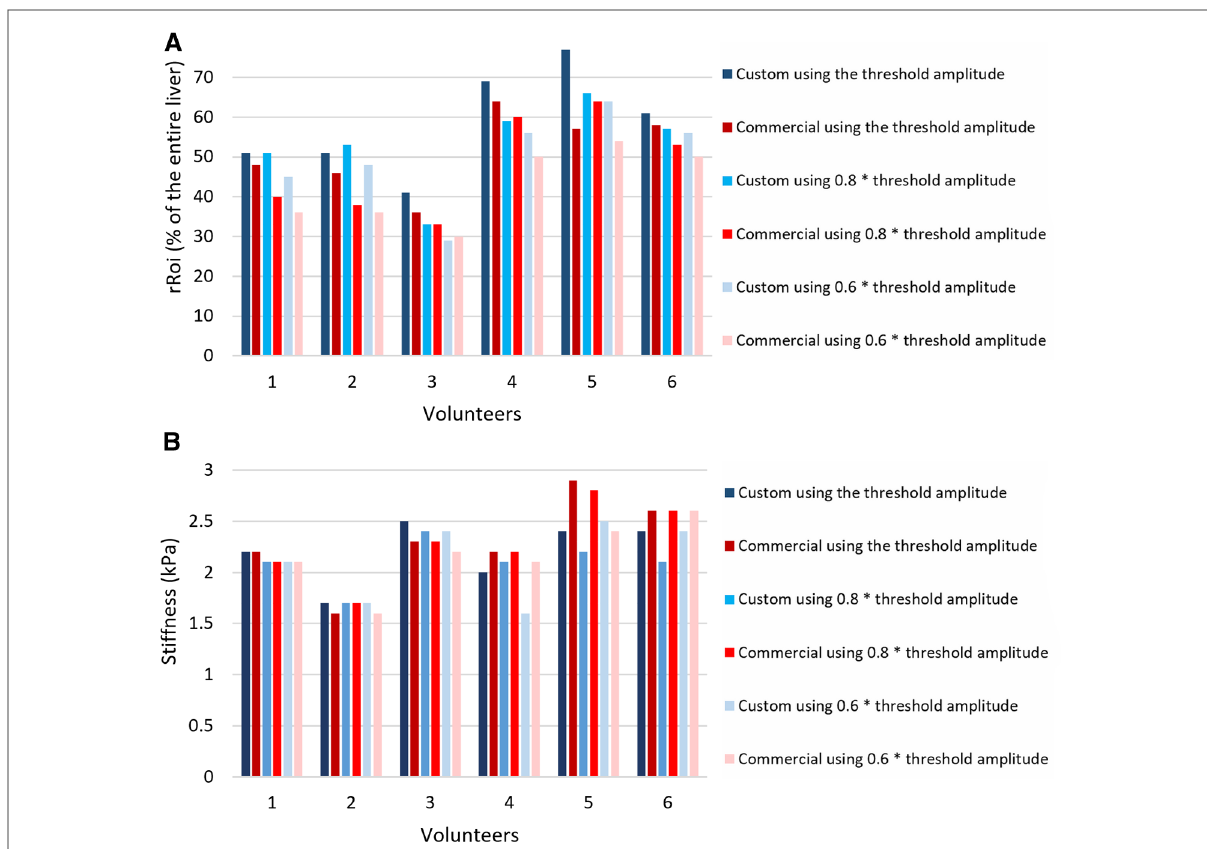
FIGURE 5 ( A ) Relative rROI area as a fraction of the entire liver averaged over the four slices, expressed in %, for different excitation amplitudes, using the custom passive driver and the commercial one in adult volunteers. ( B ) Stiffness values of the rROI area-weighted (kPa). rROI, representative